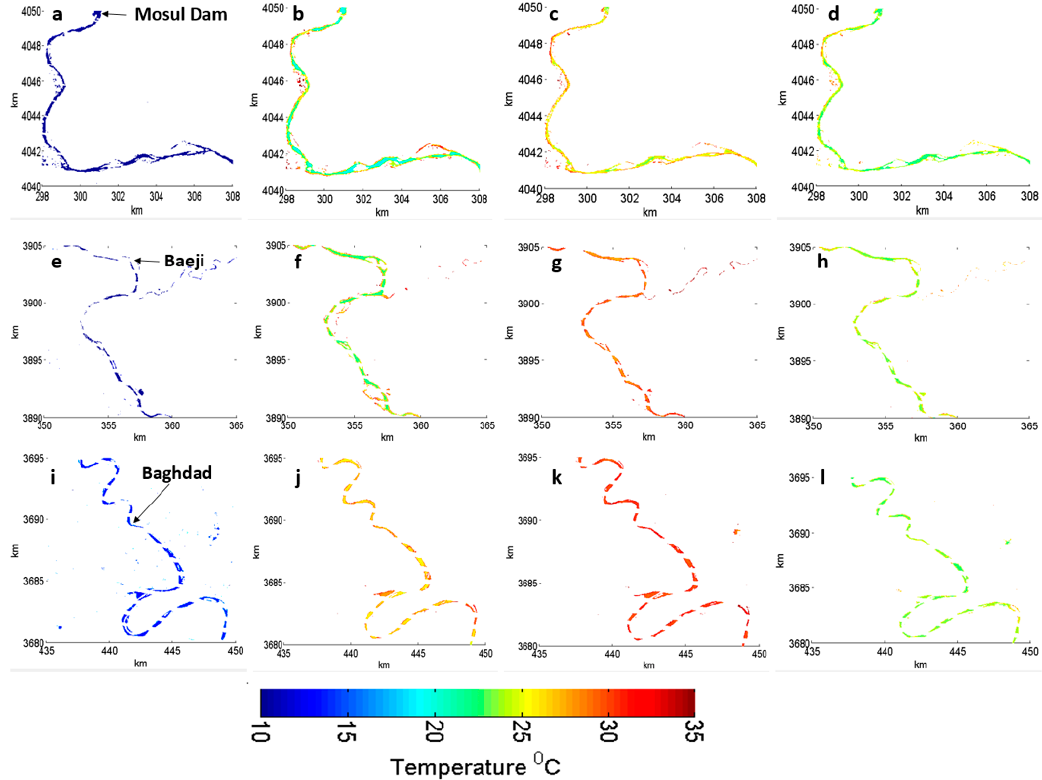
Figure 3. Seasonal variation in T w in 2009, estimated from Landsat satellite images for Mosul Dam on ( a ) 10 January; ( b ) 26 May; ( c ) 30 August; ( d ) 1 October for Baeji on ( e ) 4 February ; ( f ) 27 May; ( g ) 15 August; ( h ) 2 October and for Baghdad on ( i ) 4 February; ( j ) 27 May; ( k ) 15 August; ( l ) 2 October.